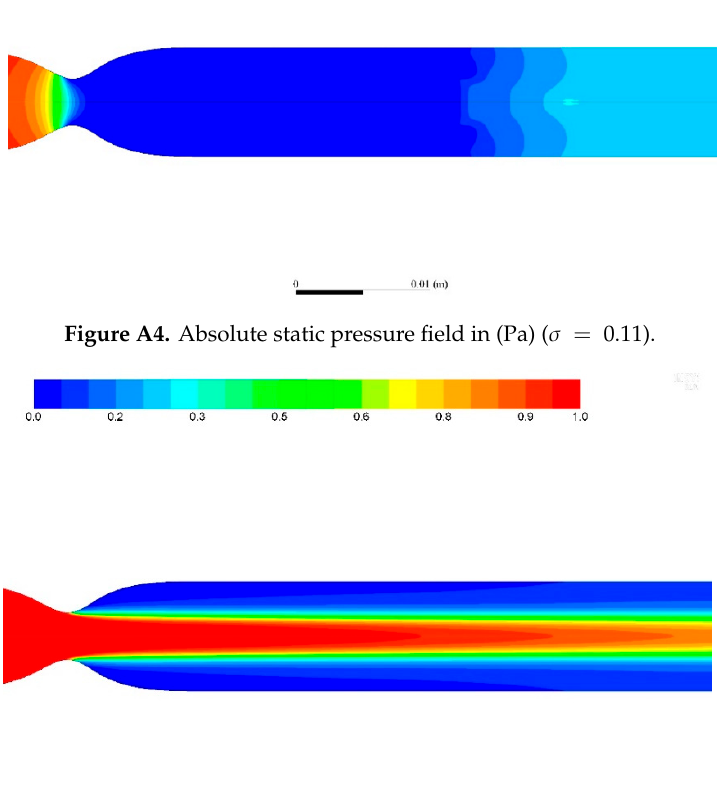
Figure A3. Velocity field (in m.s − 1 ) ( 𝜎 = 0.11 ).